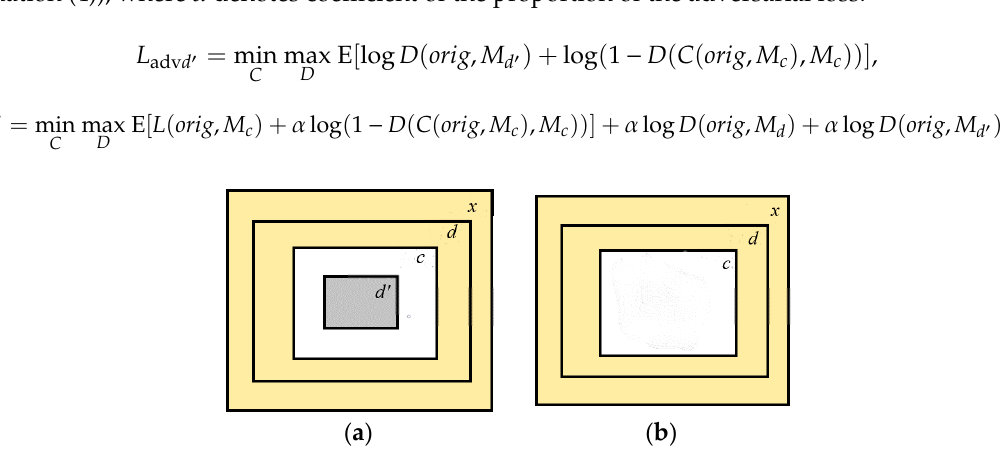
Figure 2. ( a ) Iizuka’s method; ( b ) Our method. x denotes the input image, d denotes the image block centered on the missing area in the image, c denotes the missing area, and d' denotes the image block located at the center of the missing area and having a size of 1/4 of the missing area.